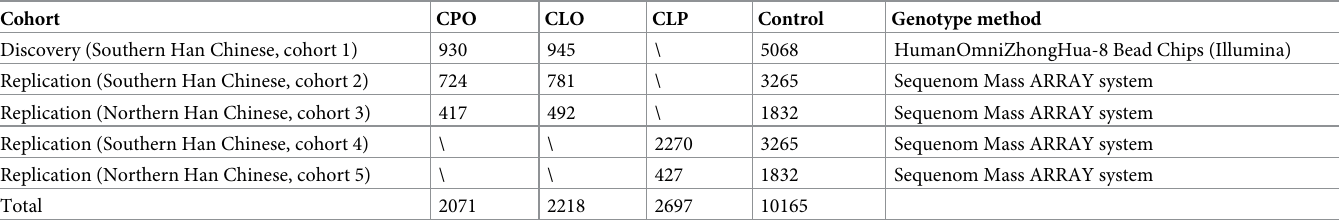
Table 1. Sample collection for the